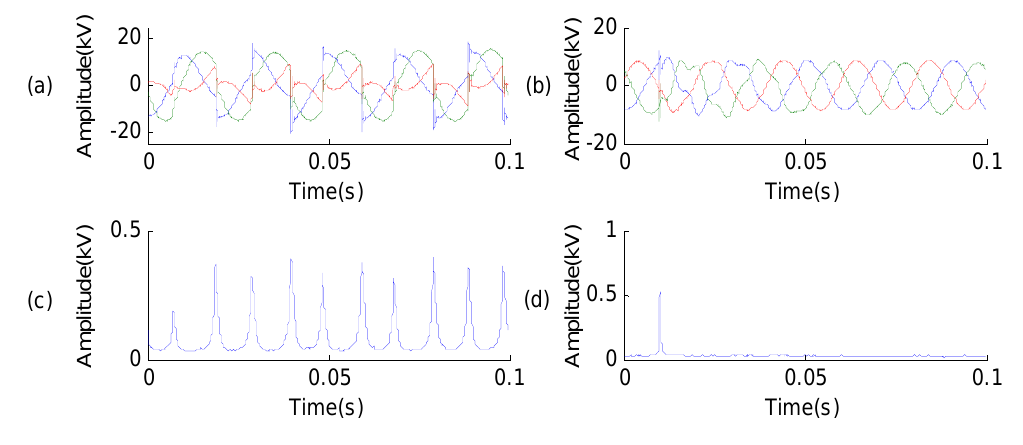
(7) The main feature of lightning and line switching over-voltage is shown in their high frequency oscillation. General, the power frequency component will not change too much after these two over-voltages take place. Typical waveforms of lightning and line switching are shown in Figures 8a,b. Figure 8. ( a ) Lightning; ( b ) Line switching; ( c ) Transient oscillation of lightning; ( d ) Transient oscillation of line switching; ( e ) Mean amplitude curve of lightning; ( f ) Mean amplitude curve of line switching.